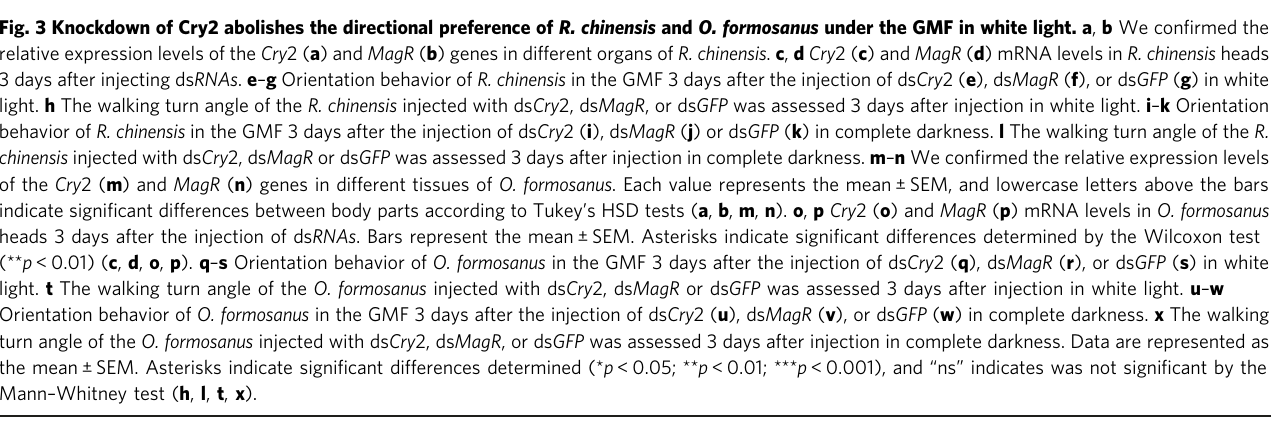
Fig. 3 Knockdown of Cry2 abolishes the directional preference of R. chinensis and O. formosanus under the GMF in white light. a , b We con fi rmed the relative expression levels of the Cry 2 ( a ) and MagR ( b ) genes in different organs of R. chinensis . c , d Cry 2 ( c ) and MagR ( d ) mRNA levels in R. chinensis heads 3 days after injecting ds RNAs . e – g Orientation behavior of R. chinensis in the GMF 3 days after the injection of ds Cry 2 ( e ), ds MagR ( f ), or ds GFP ( g ) in white light. h The walking turn angle of the R. chinensis injected with ds Cry 2, ds MagR , or ds GFP was assessed 3 days after injection in white light. i – k Orientation chinensis injected with ds Cry 2, ds MagR or ds GFP was assessed 3 days after injection in complete darkness. m – n We con fi rmed the relative expression levels indicate signi fi cant differences between body parts according to Tukey ’ s HSD tests ( a , b , m , n ). o , p Cry 2 ( o ) and MagR ( p ) mRNA levels in O.